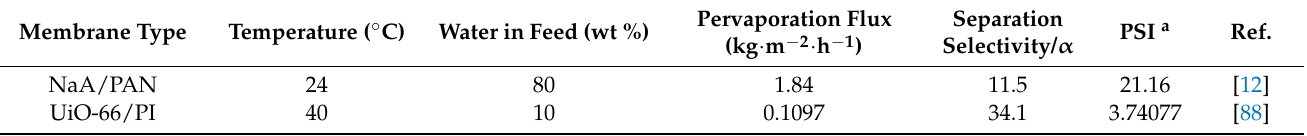
Table 3. Comparison of parameters of different MMMs in DMF separation. Membrane Type Temperature ( ◦